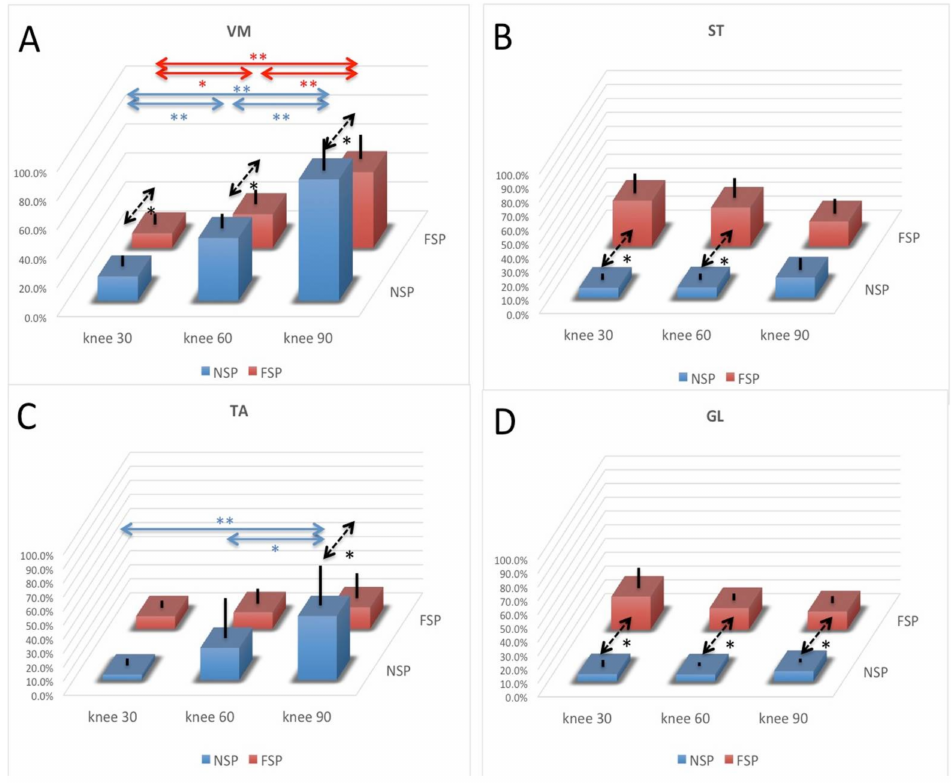
Figure 1. Muscle activity compared at different knee flexion angles in the FSP and NSP. Muscle activity is compared at different knee flexion angles of 30 ◦ , 60 ◦ , and 90 ◦ in the FSP and NSP. The measured muscles are vastus medialis (VM, ( A )), semitendinosus (ST, ( B )), tibialis anterior (TA, ( C )), and gastrocnemius muscle lateral head (GL, ( D )). Muscle activity is normalized using the integrated EMG at maximum voluntary isometric contraction. Black arrows show the differences between the FSP and NSP, which were previously reported. * Significant difference ( p < 0.05) for multiple comparisons. ** Significant difference ( p < 0.01).